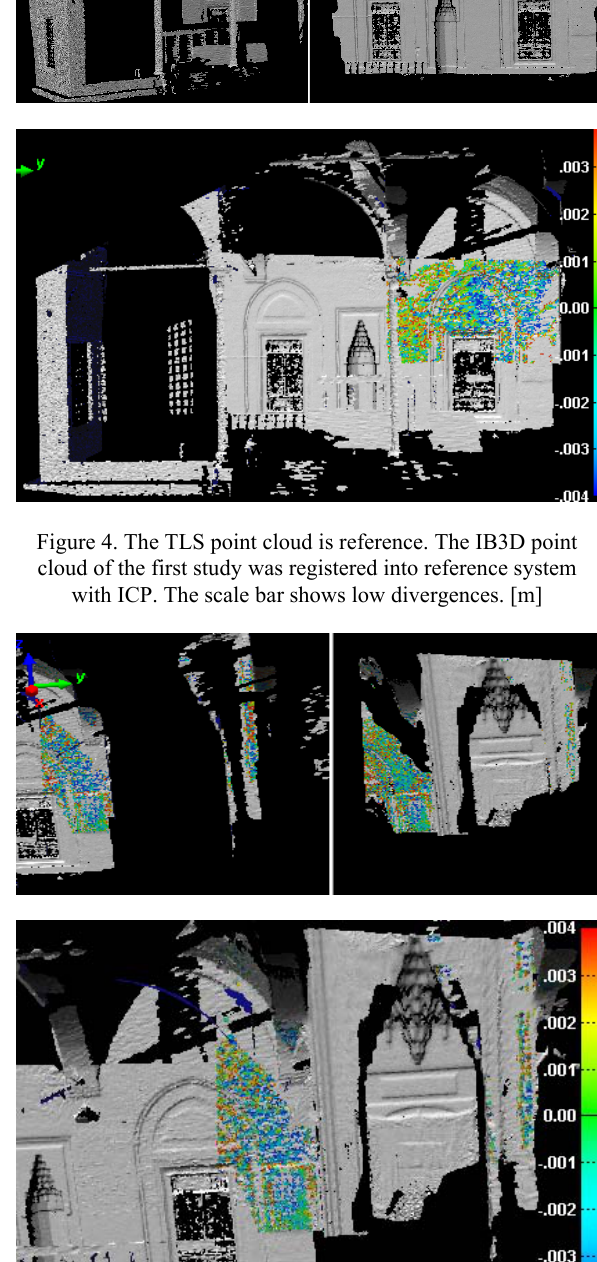
Figure 2. Dense IB3D point cloud. The first study.